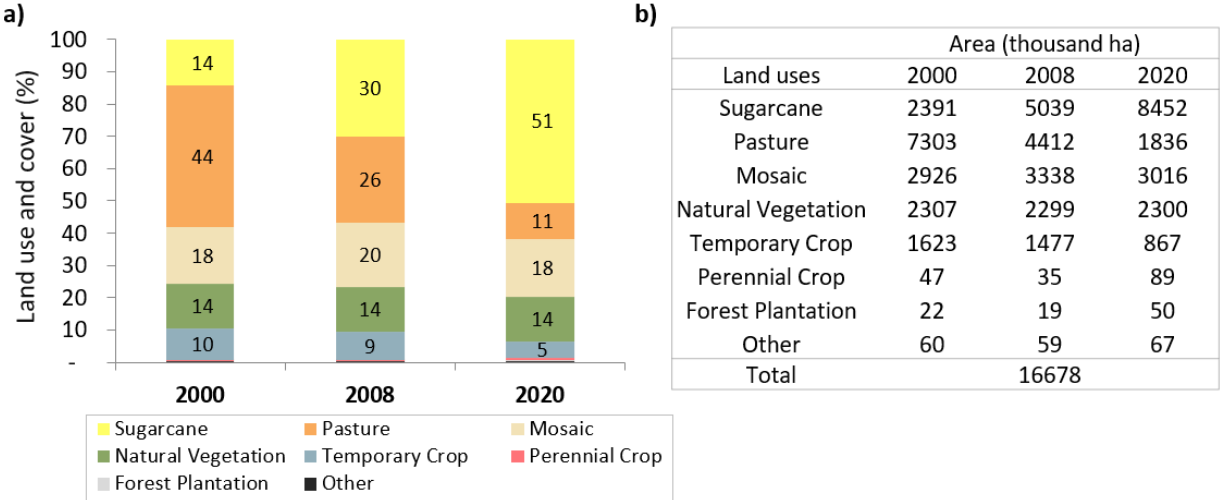
Figure 3. Share ( a ) and area ( b ) of each land use and land cover class within the assessed rural properties (CARs) with sugarcane cultivation, in the years 2000, 2008, and 2020, in Brazil’s center- south and north regions.